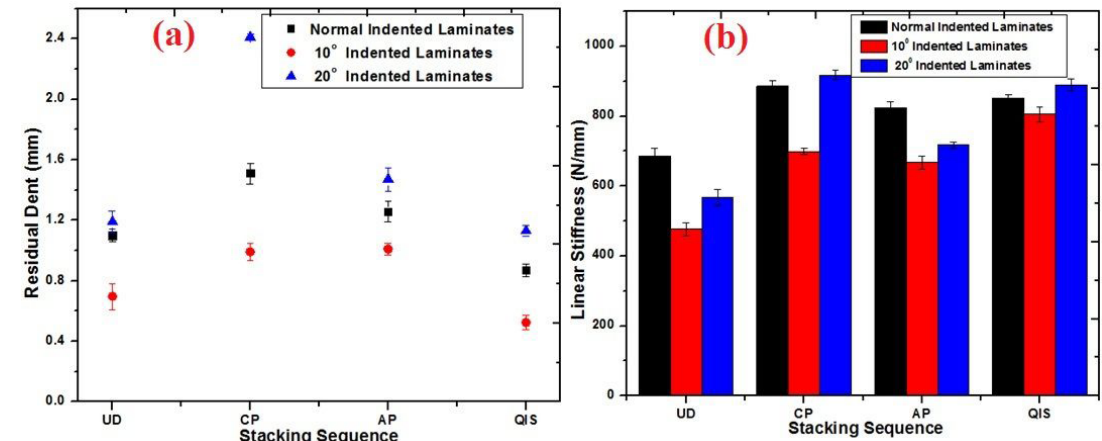
Figure 4. Evaluation of damage resistance (a) Residual dent and (b) Linear